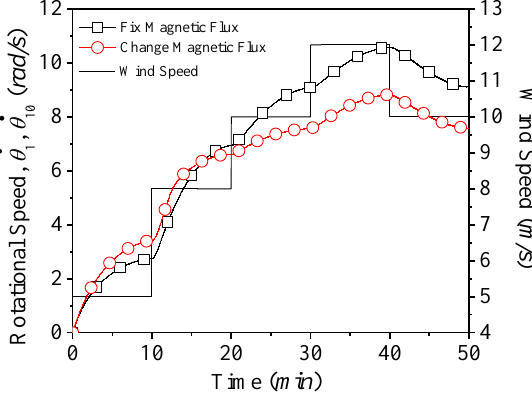
Figure 13. Rotational variation for the input shaft.